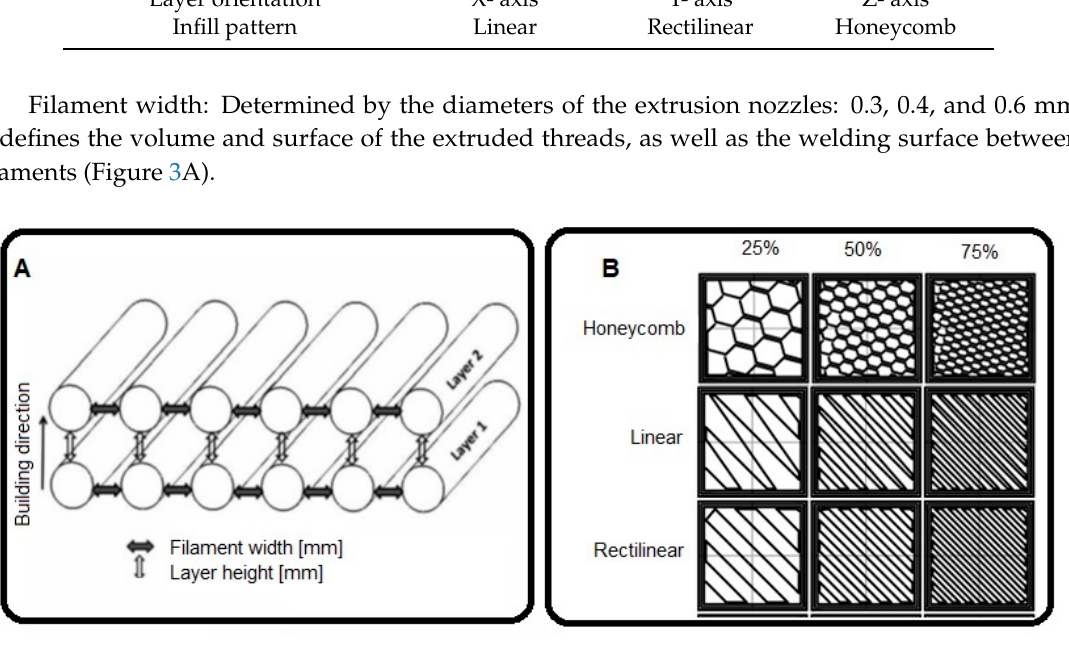
Figure 3. Schematic representation of the parameters used in the study: ( A ) filament width and layer height, ( B ) infill pattern and fill density.